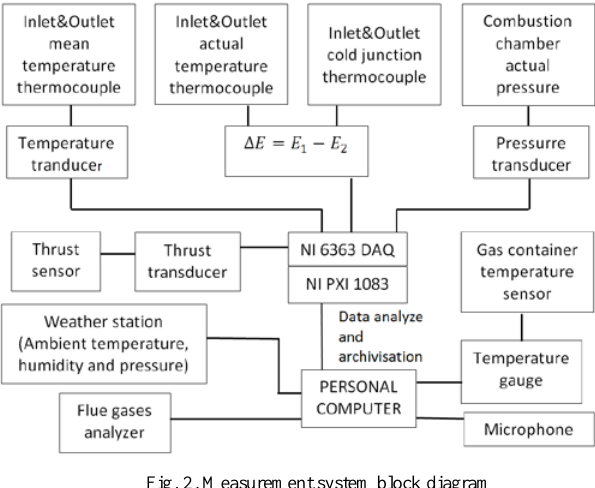
Fig. 2. Measurement system block